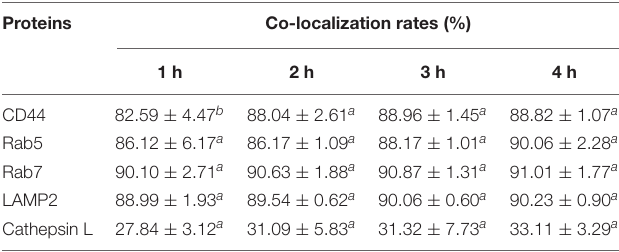
TABLE 2 | Co-localization rates of GFP-labeled C. sakazakii with endocytosis-related proteins in HBMEC.